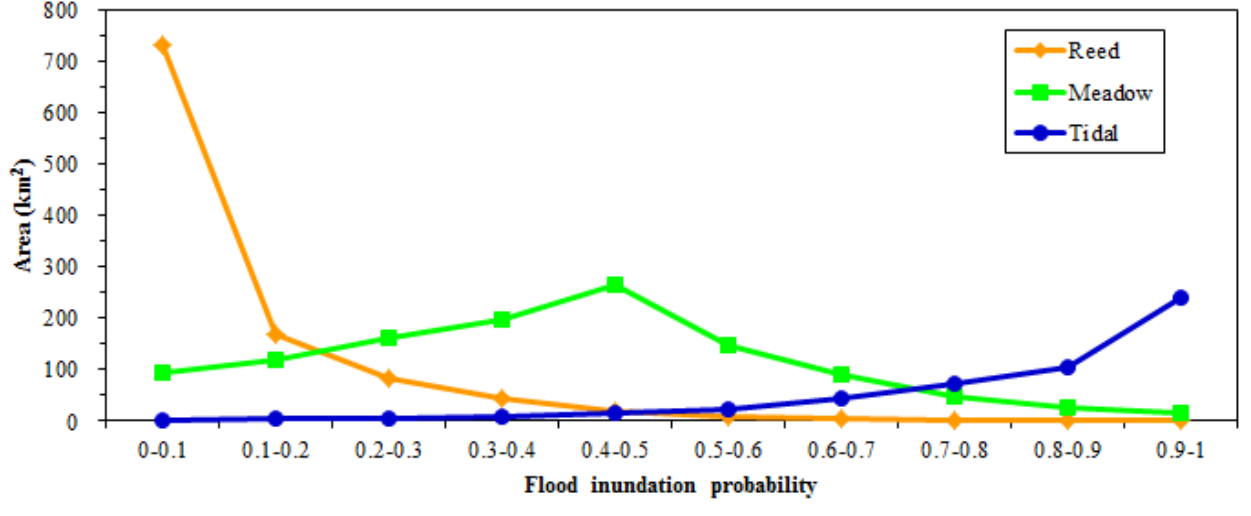
Figure 8. Variations in average areas of reed, meadow, and tidal wetlands with the change in flood inundation probability over the period from 2000 to 2012 in the Dongting